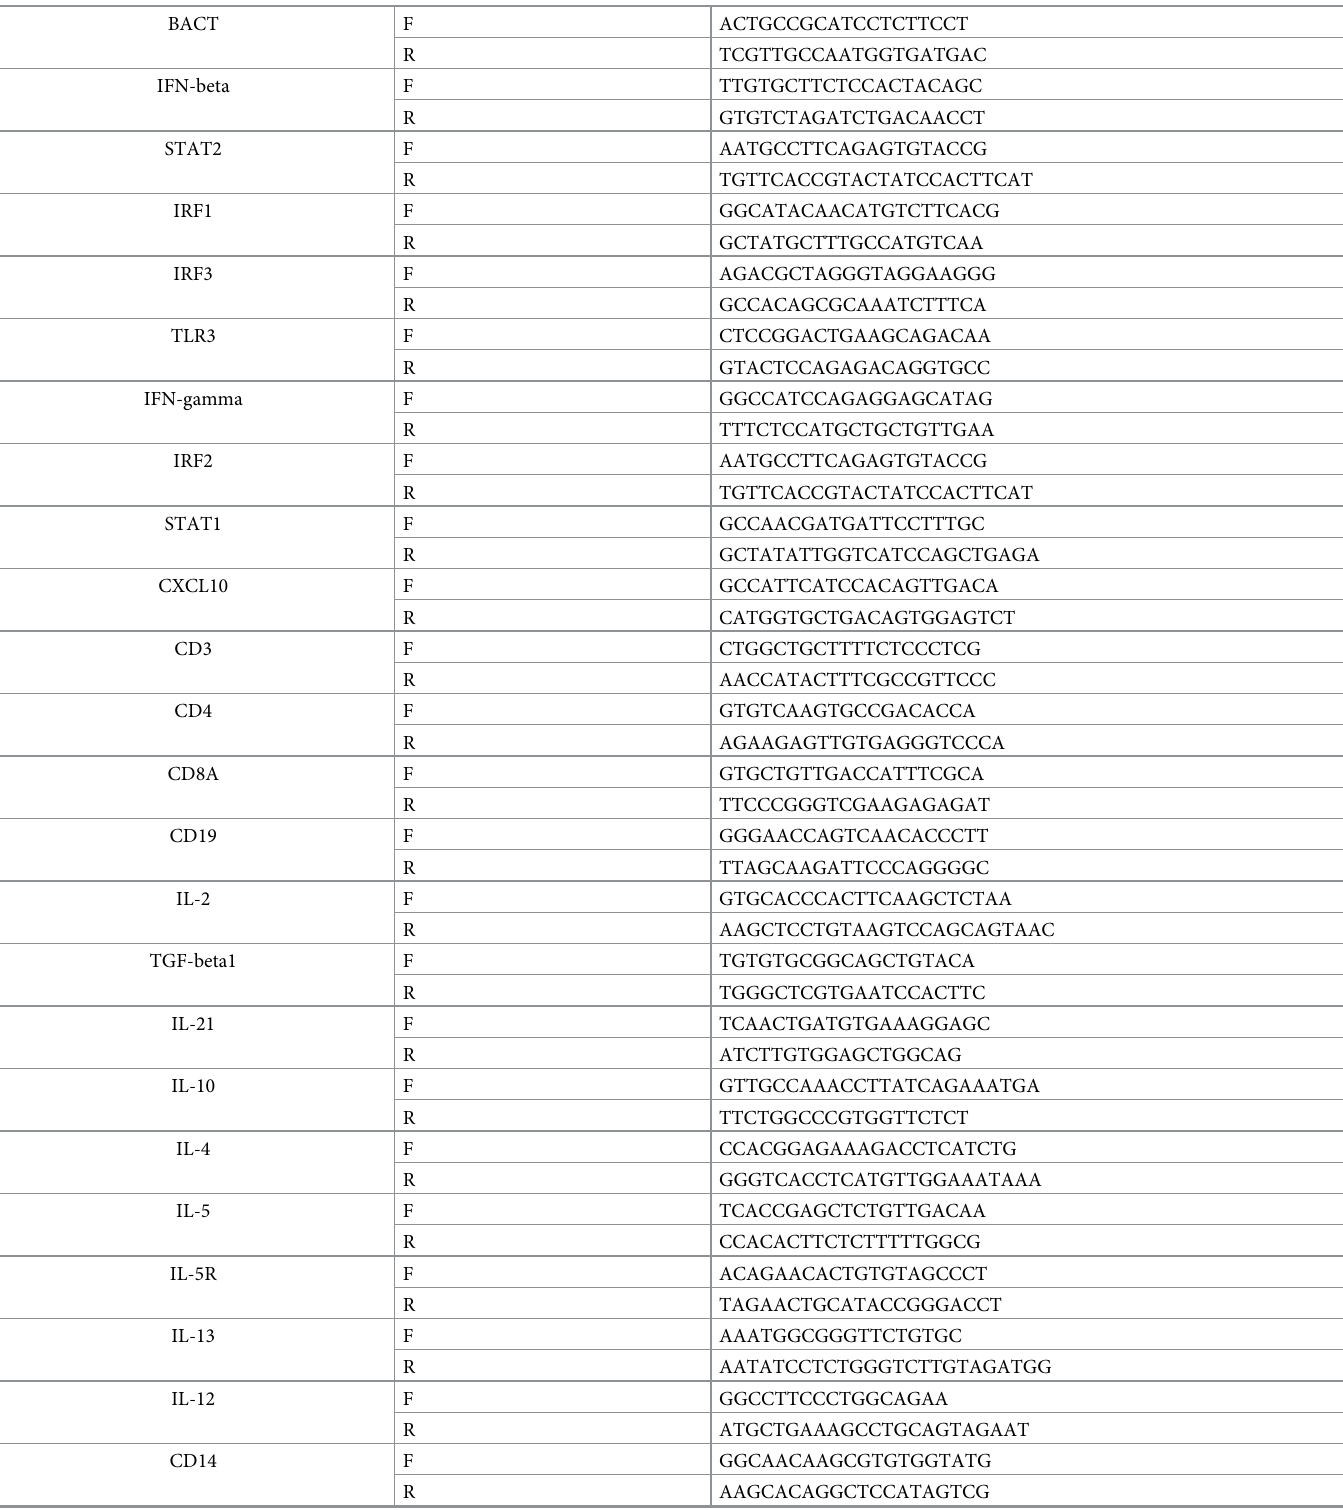
Table 1. Syrian Hamster qRT-PCR